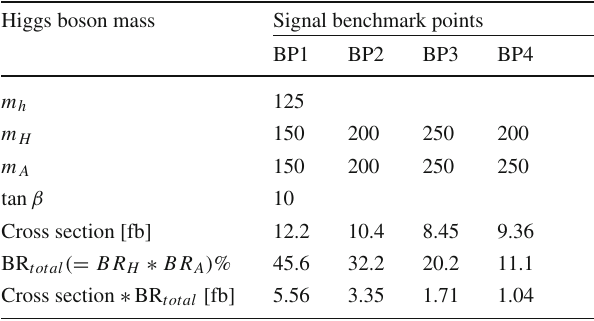
Table 2 Signal benchmark points and their cross sections and branch- ing ratios used in the analysis. BR denotes the branching ratio of Higgs boson decay to b ¯ b